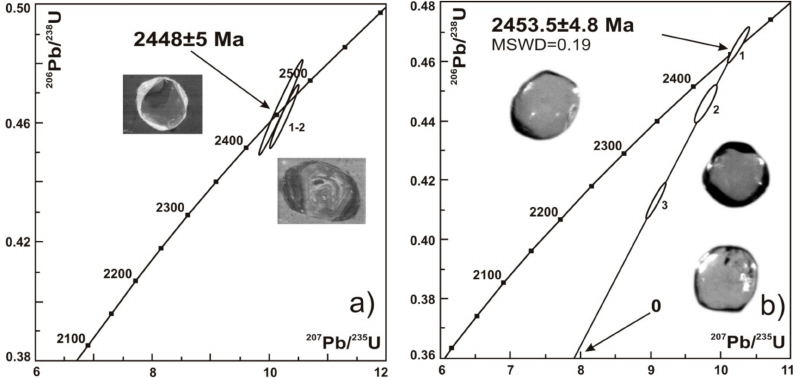
Figure 6. Isotope U–Pb diagrams for single zircon grains from metagabbro of the Kolvitsa (sample 200) ( a ) and metagabbro of the Kandalaksha (sample 183) ( b ) massifs.